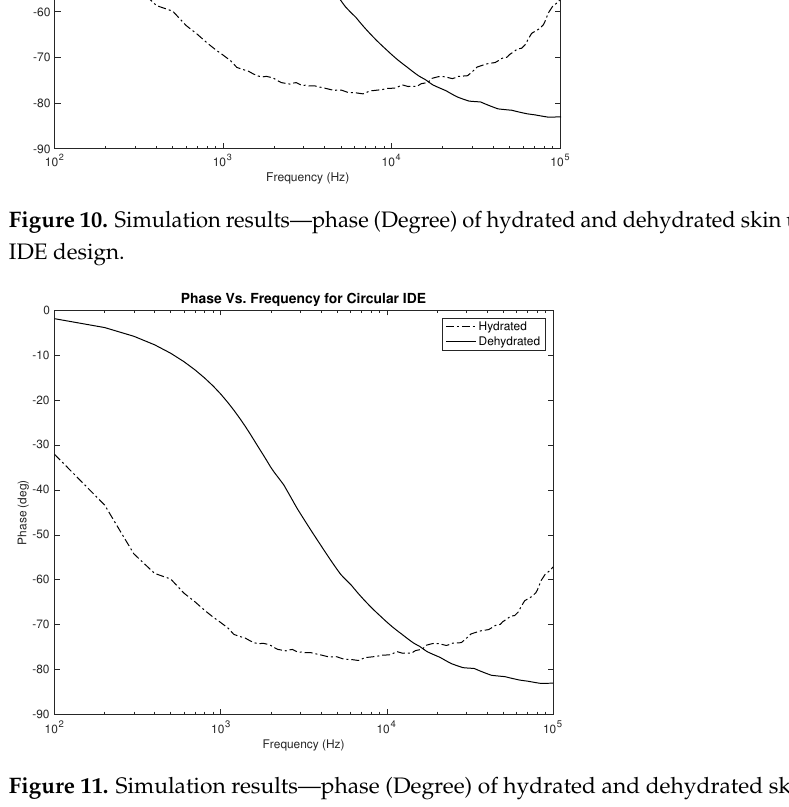
Figure 11. Simulation results—phase (Degree) of hydrated and dehydrated skin using the circular IDE